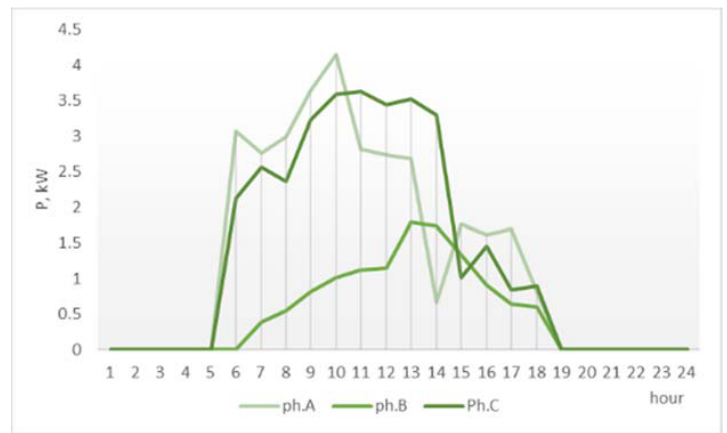
Figure 15. Prosumer surplus in network R121.